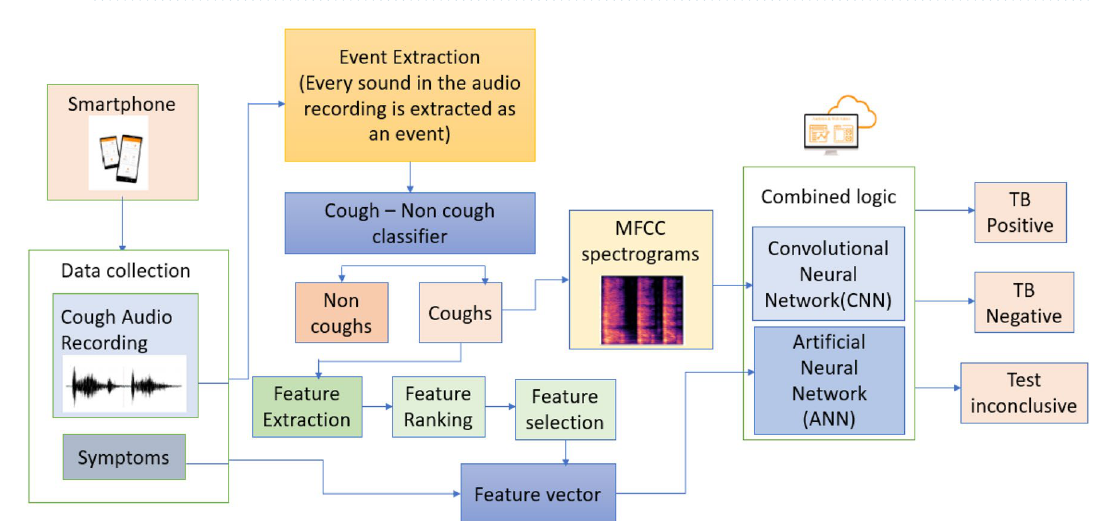
Figure 3. Block Diagram illustrating the flow of the TB prediction